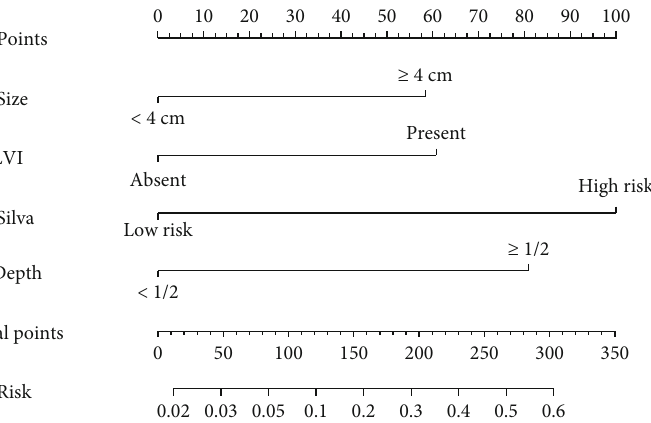
Figure 1: Nomogram for predicting LNM.